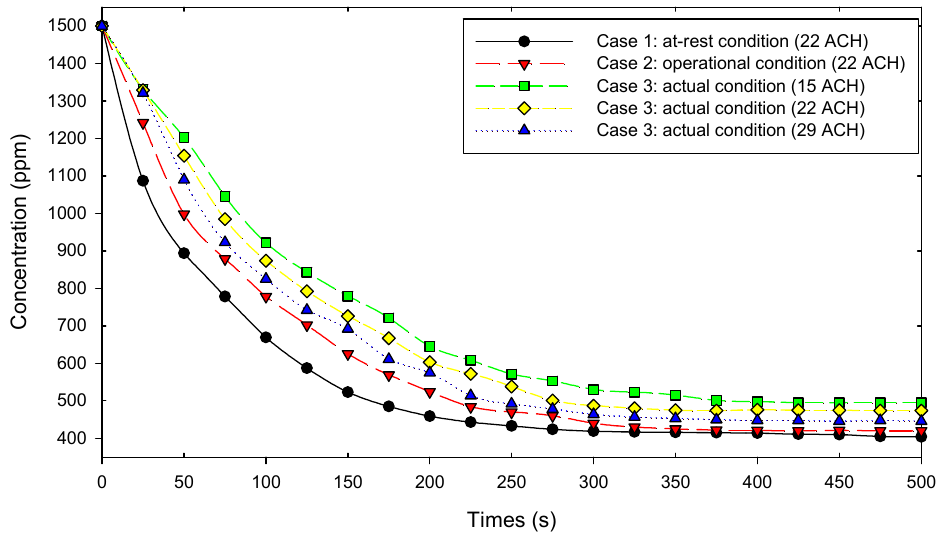
Figure 8. Concentration decay effect in different schemes.